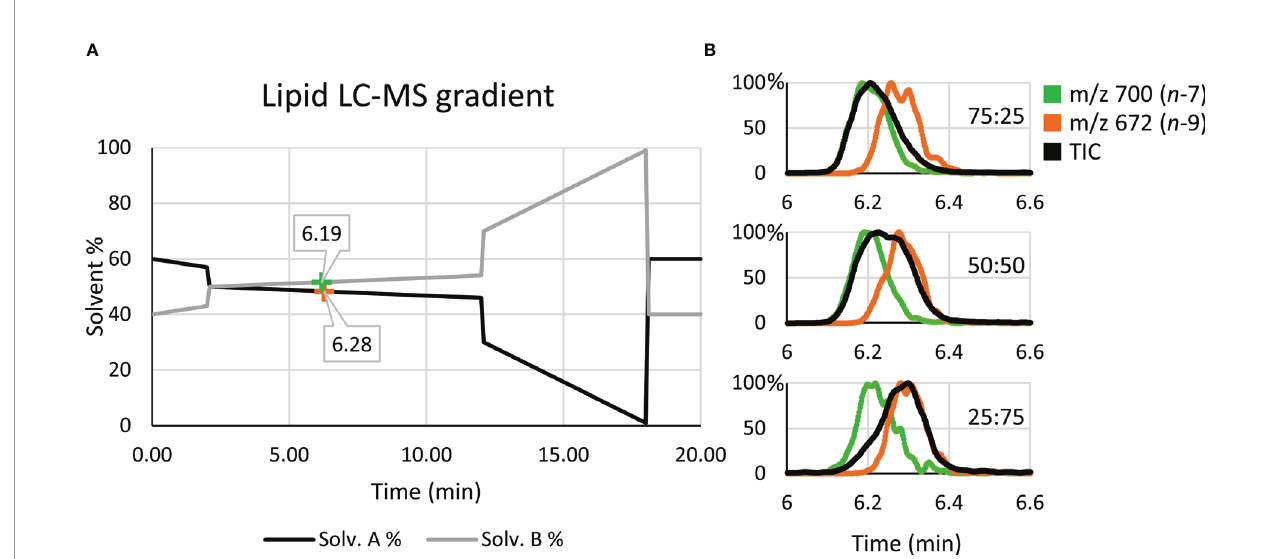
FIGURE 4 | Liquid chromatography solvent gradient and elution pro fi les of isomeric reference standards. (A) Using OzID fragment XICs, the retention times for PC 16:0/18:1 n -7 (green) and PC 16:0/18:1 n -9 (orange) are mapped along the solvent gradient. (B) The use of OzID fragment XICs, such as m/z 700 (green) and m/z 672 (orange), resolve the quantitative accuracy issues arising from the poor isomer separation observed in the TIC